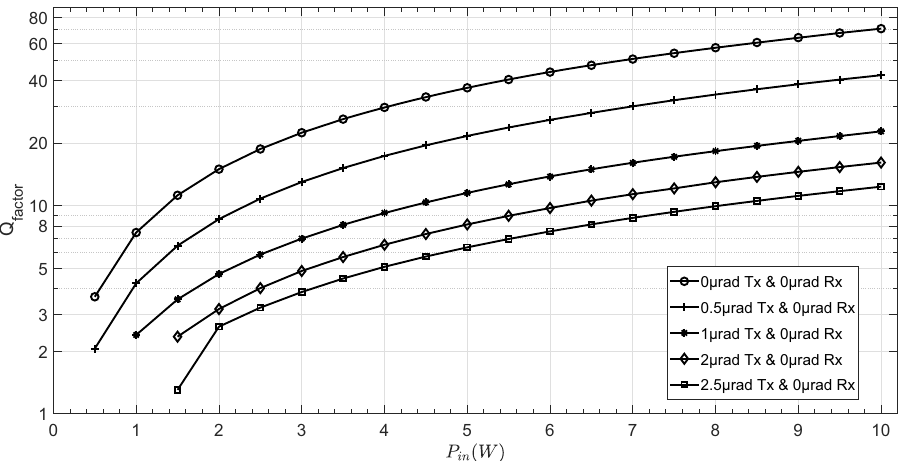
Figure 8: Quality factor ( Q factor ) as a function of the transmitted laser power ( P W in ( ) ) for a di ff erent transmitter only pointing error.